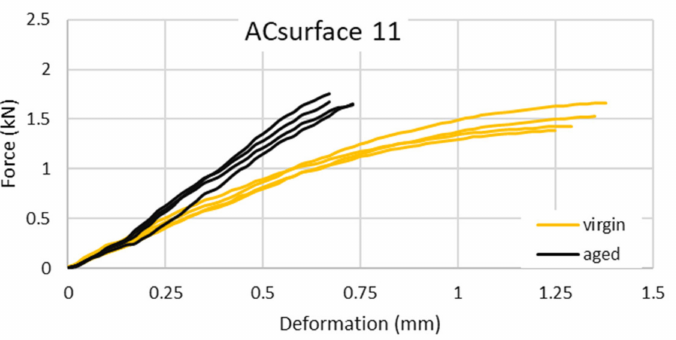
Figure 1. Example of force-displacement diagram for 3-point bending test—AC surface 11